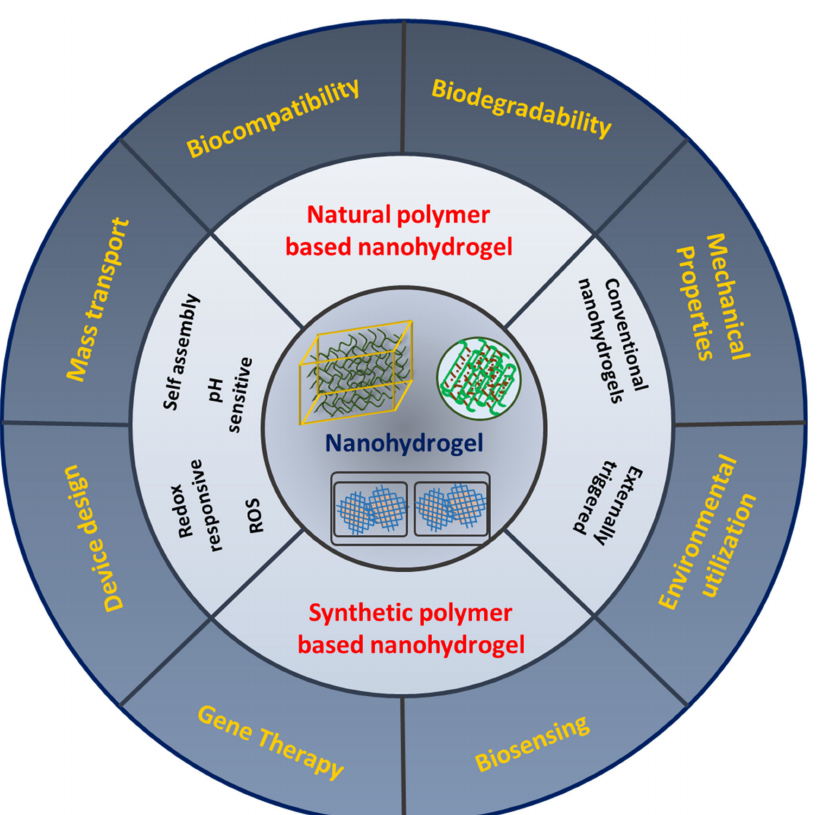
Figure 1. Schematic representation of nanohydrogel engineering based on the source of origin and applied functional role of nanohydrogels in